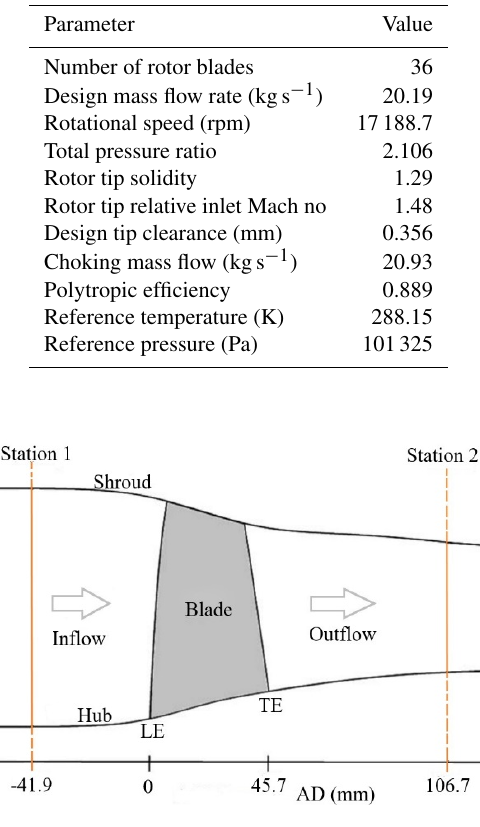
Figure 1. NASA rotor 37 Meridional